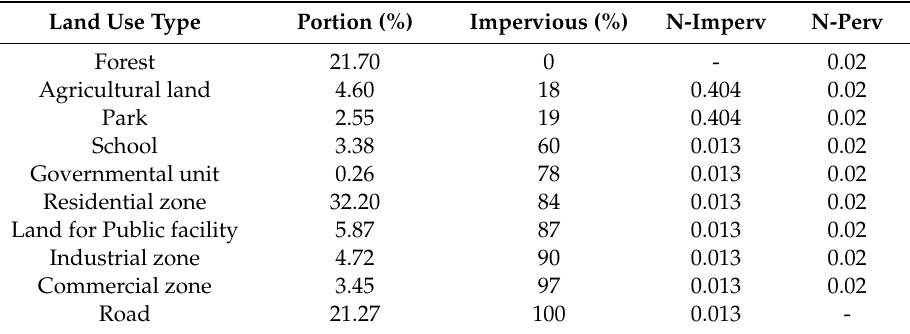
Table 2. The parameters for